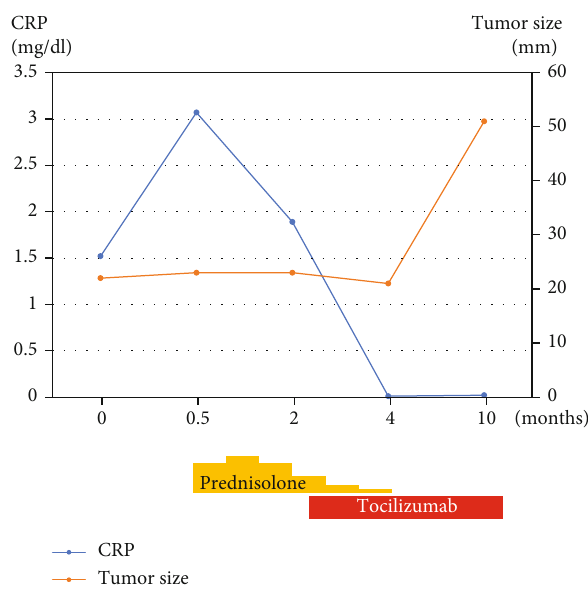
Figure 4: Scheme of the treatment indicating the tumor sizes and CRP levels. The time of tumor recurrence was regarded as time